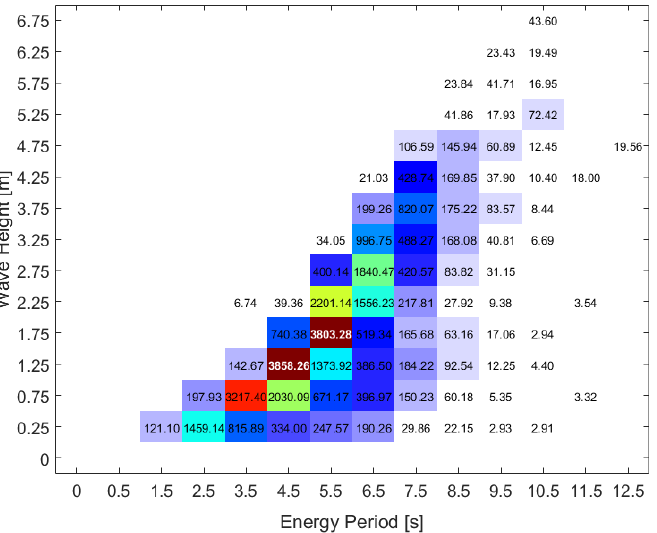
Figure 17. Scatter diagram on the annual energy production for each sea state at Site 1 when the WEC was under a constant damping control of 55 kNs/m.